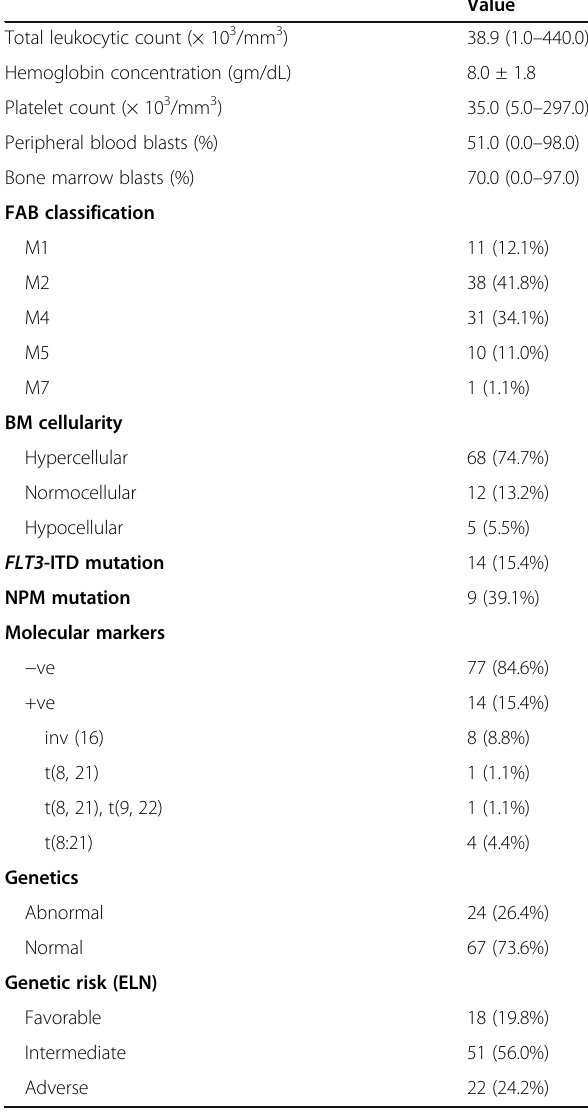
Table 1 Laboratory characteristics of the AML group (n =